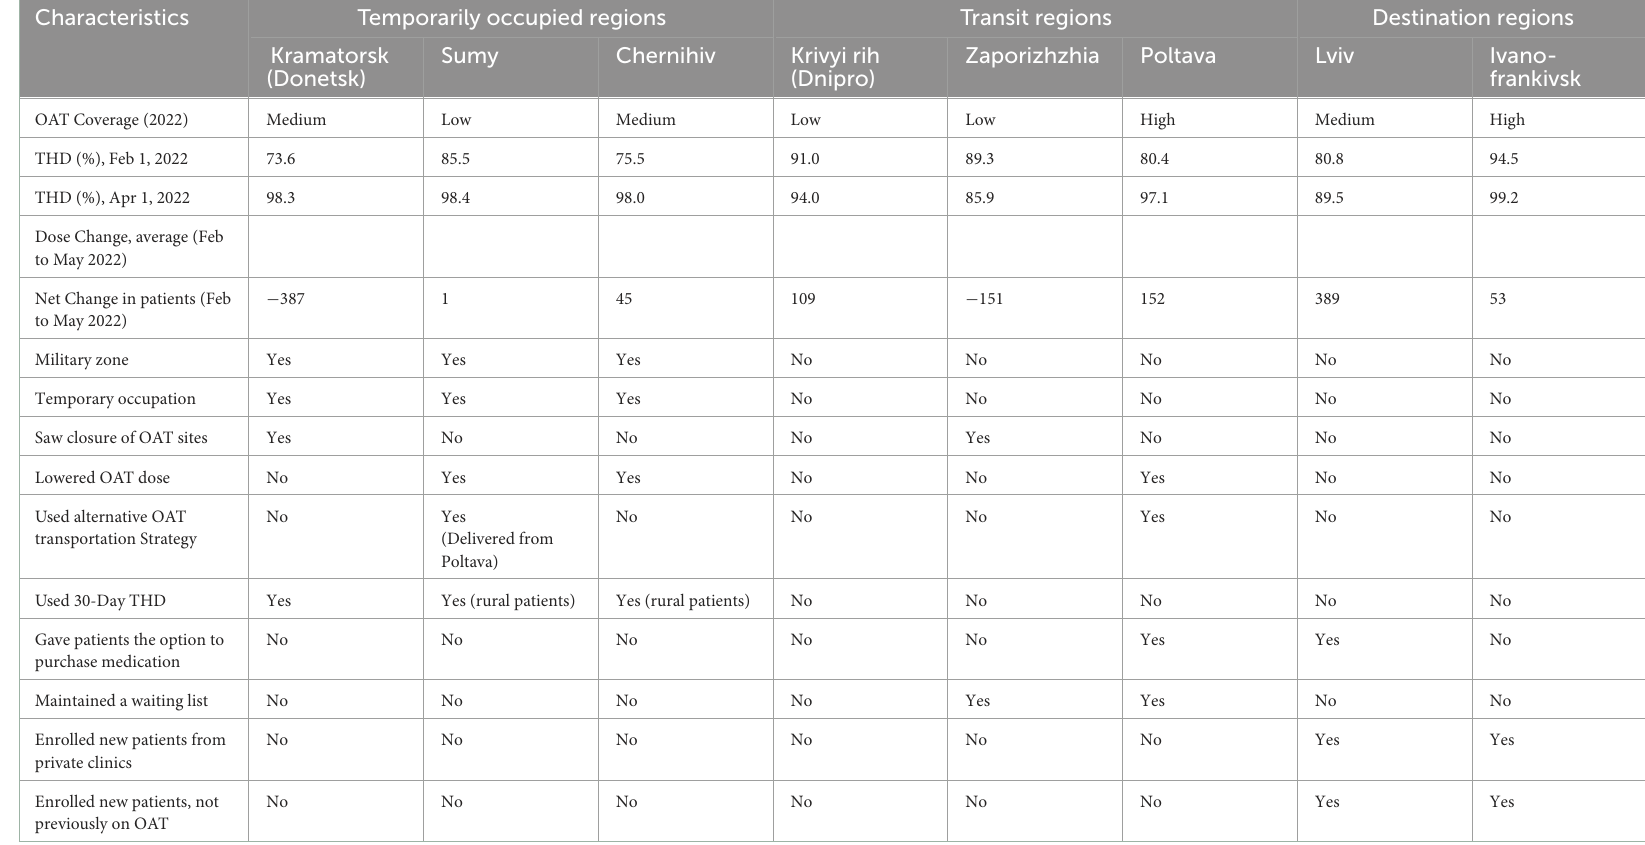
TABLE 1 Regional descriptions and responses to OAT